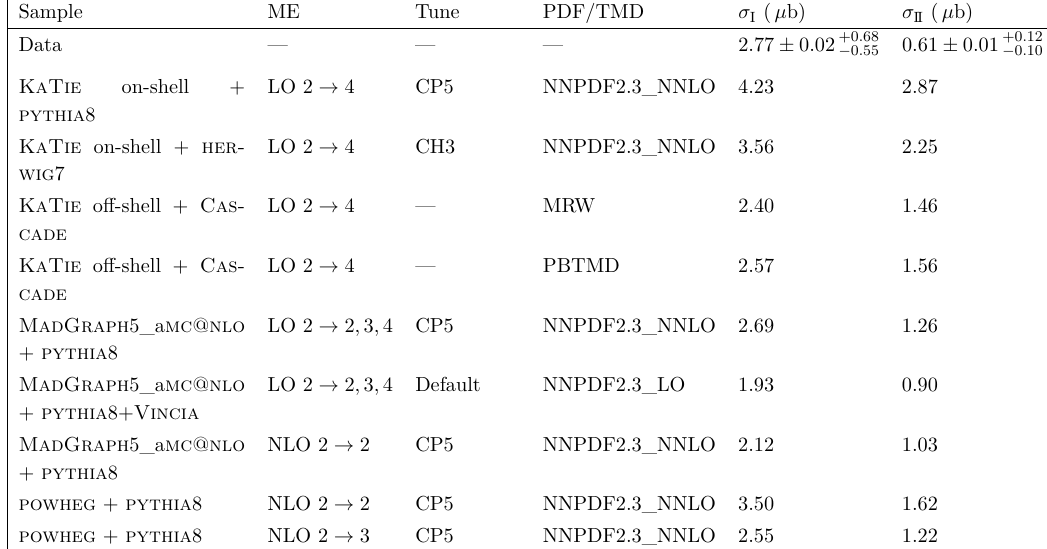
Table 4 . Cross sections obtained from data and from KaTie , MadGraph 5_a mc@nlo , and powheg in region Region I and Region II of the phase space, where ME stands for matrix